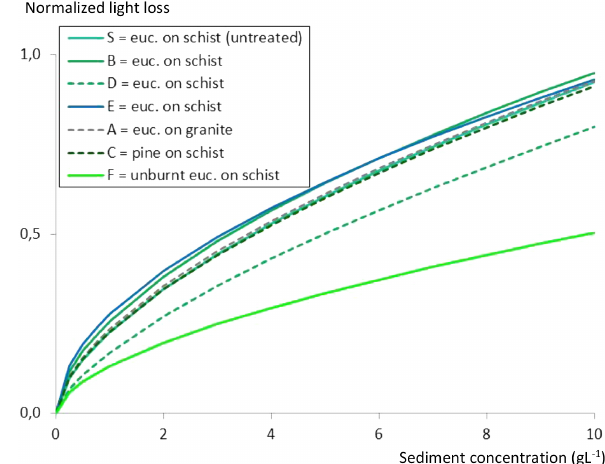
Figure 5. Best-fitting power functions of the relationships of sedi- ment concentration with normalized light loss at the slope scale for one long-unburnt eucalypt (euc.) plantation on schist (F), five re- cently burnt eucalypt (euc.) plantations on schist or granite (A, B, D, E, S) and one recently burnt pine plantation on schist (C) (see Table